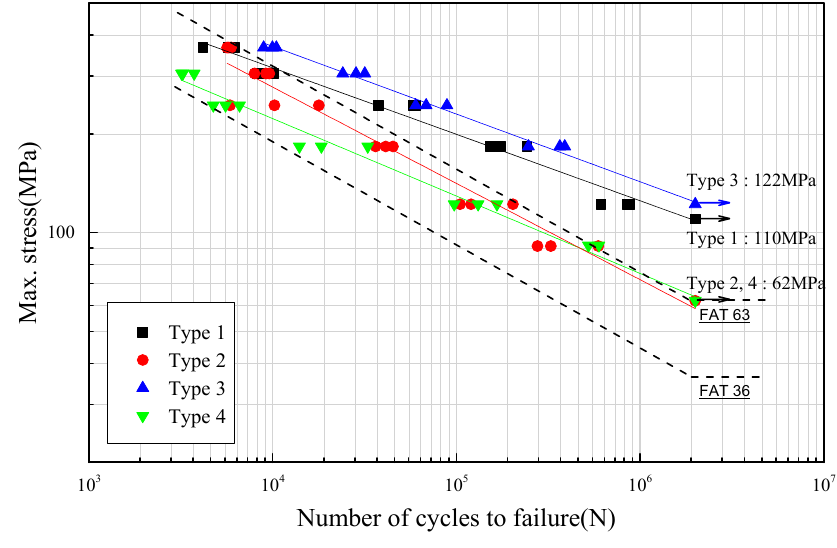
Figure 6. S–N curve according to weld type (FAT: Fatigue class).